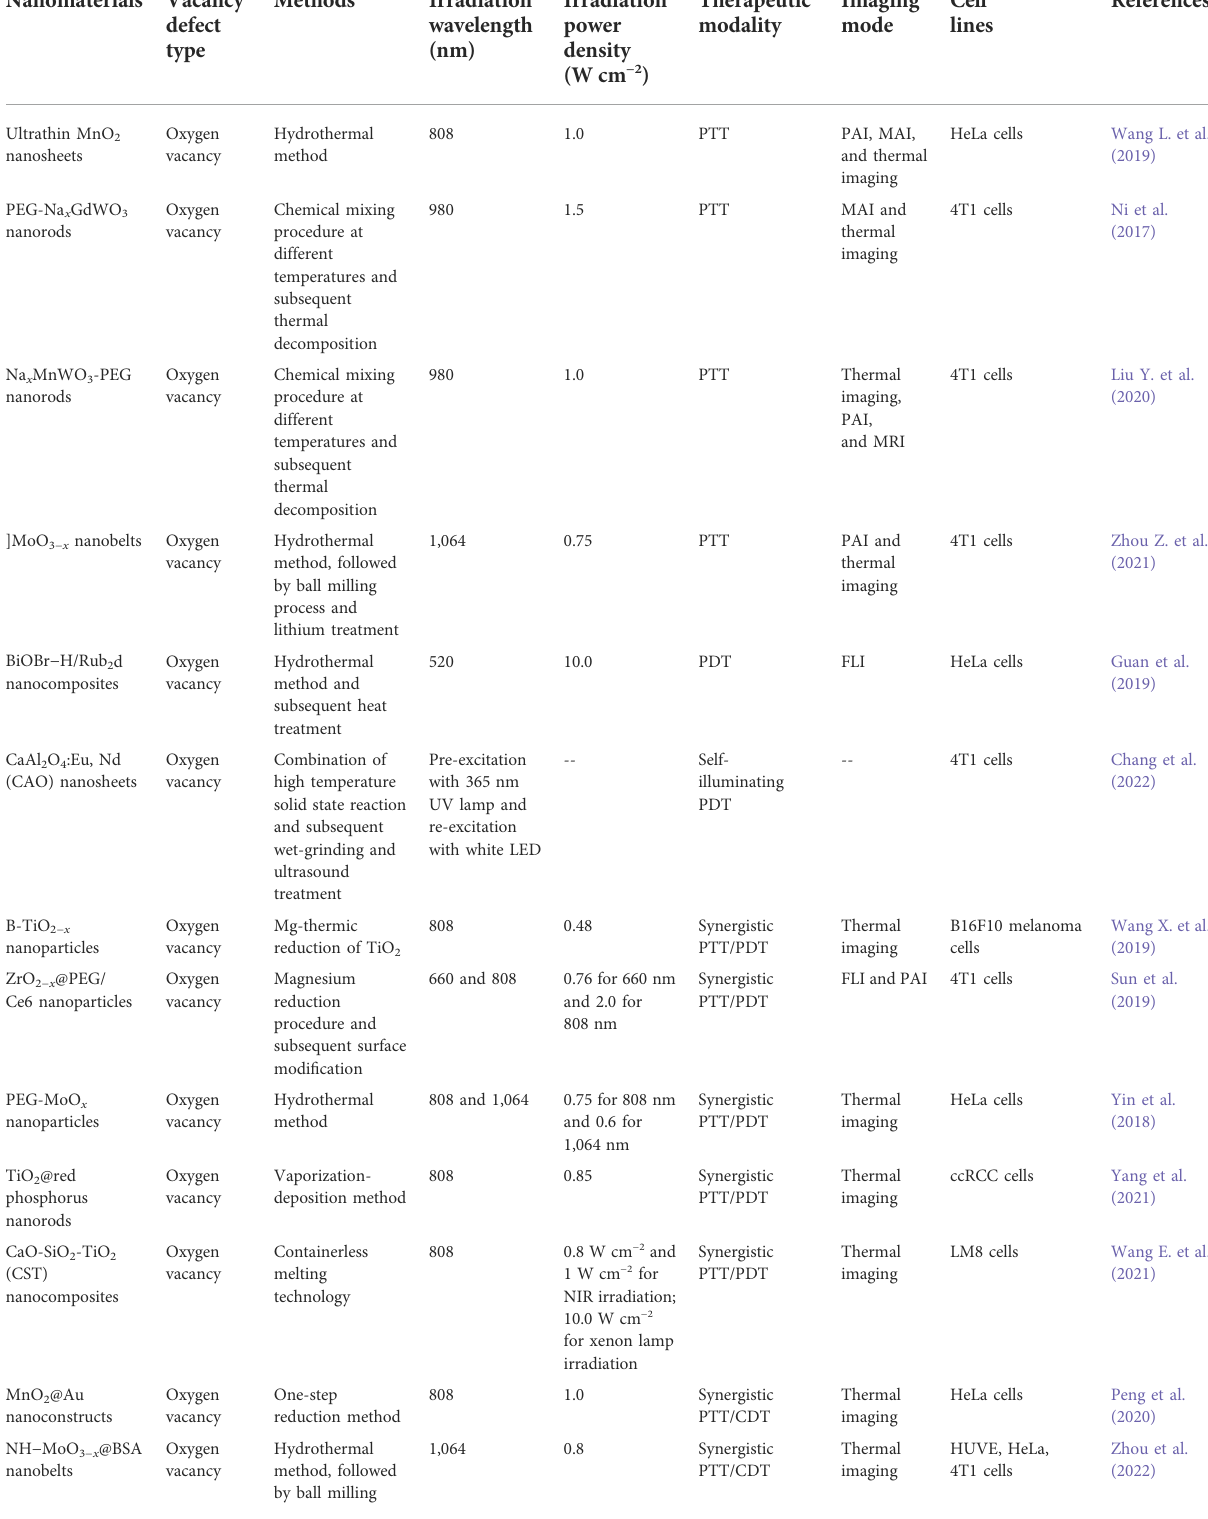
TABLE 1 Summary of the vacancy defective nanomaterials for phototherapy and multimodal synergistic phototherapy from recent reports in the literature. Nanomaterials Vacancy